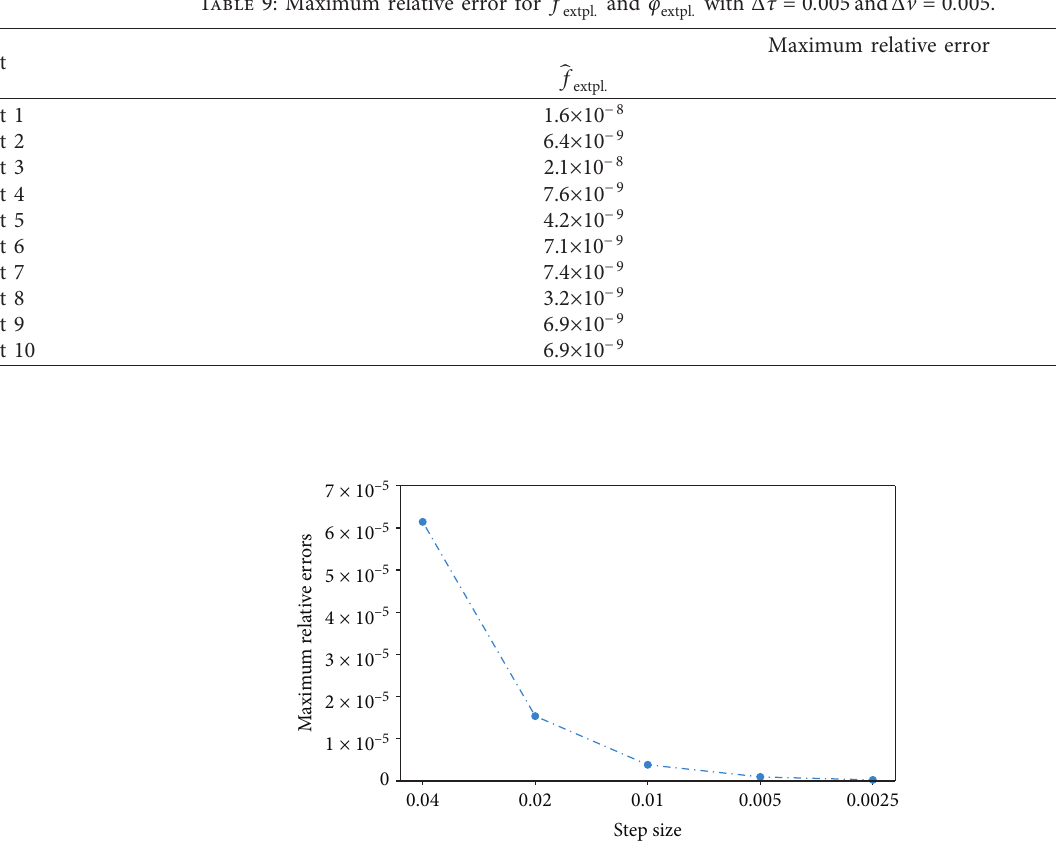
Table 9: Maximum relative error for 􏽢 f